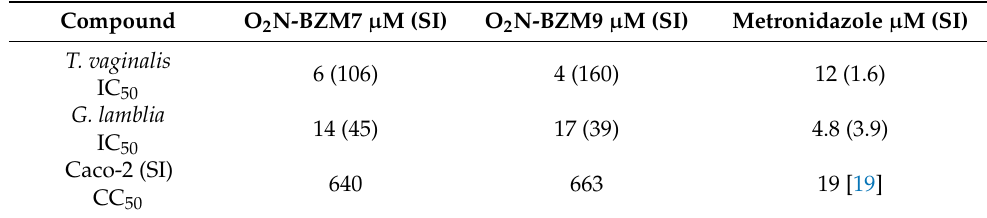
Figure 10. Antitrichomonal activity of the O 2 N-BZM7 and O 2 N-BZM9 compounds on T. vaginalis trophozoites’ viability. The trophozoites were incubated in the presence of compounds, by 24 h at 37 °C with increasing concentrations of each of the compounds, and the viability of the trophozoites was later determined. The values represent the mean ± standard deviation from three independent experiments; standard errors were lower than 5%. Table 3. In vitro antigiardial and antitrichomonal activities of compounds, and the cytotoxic activity on Caco-2 cells.